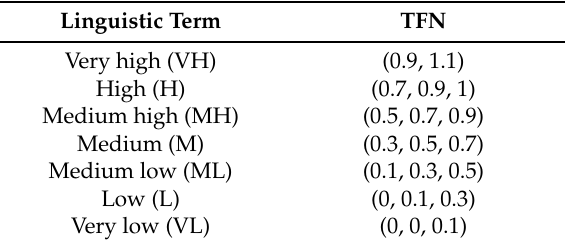
Table 1. Linguistic variables for the